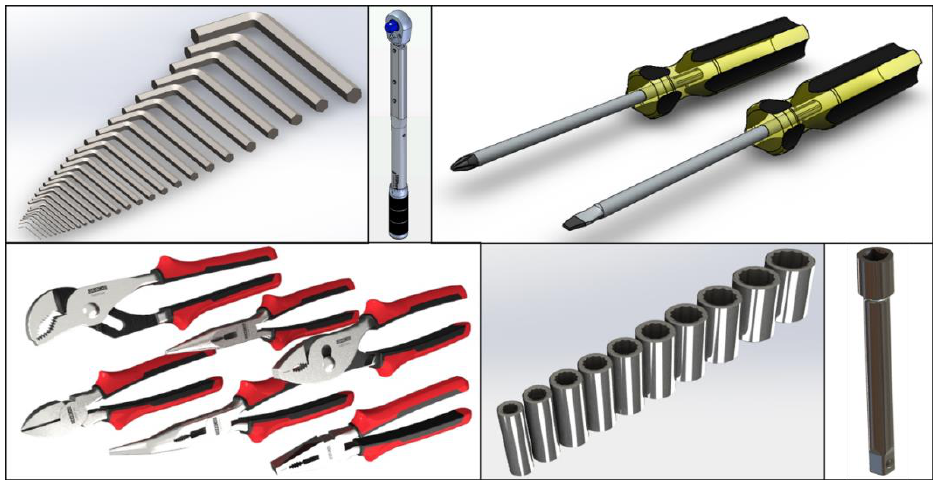
Figure 4. 3D CAD geometries of tools for AR instructions.